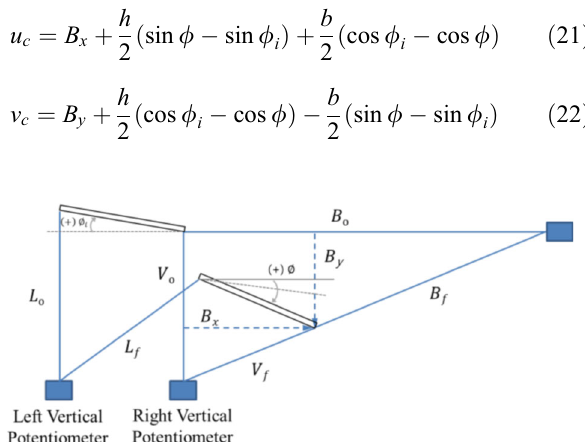
Fig. 8 Geometry configurations before and after deformation of the beam with the initial rotational angle of the cross-section.